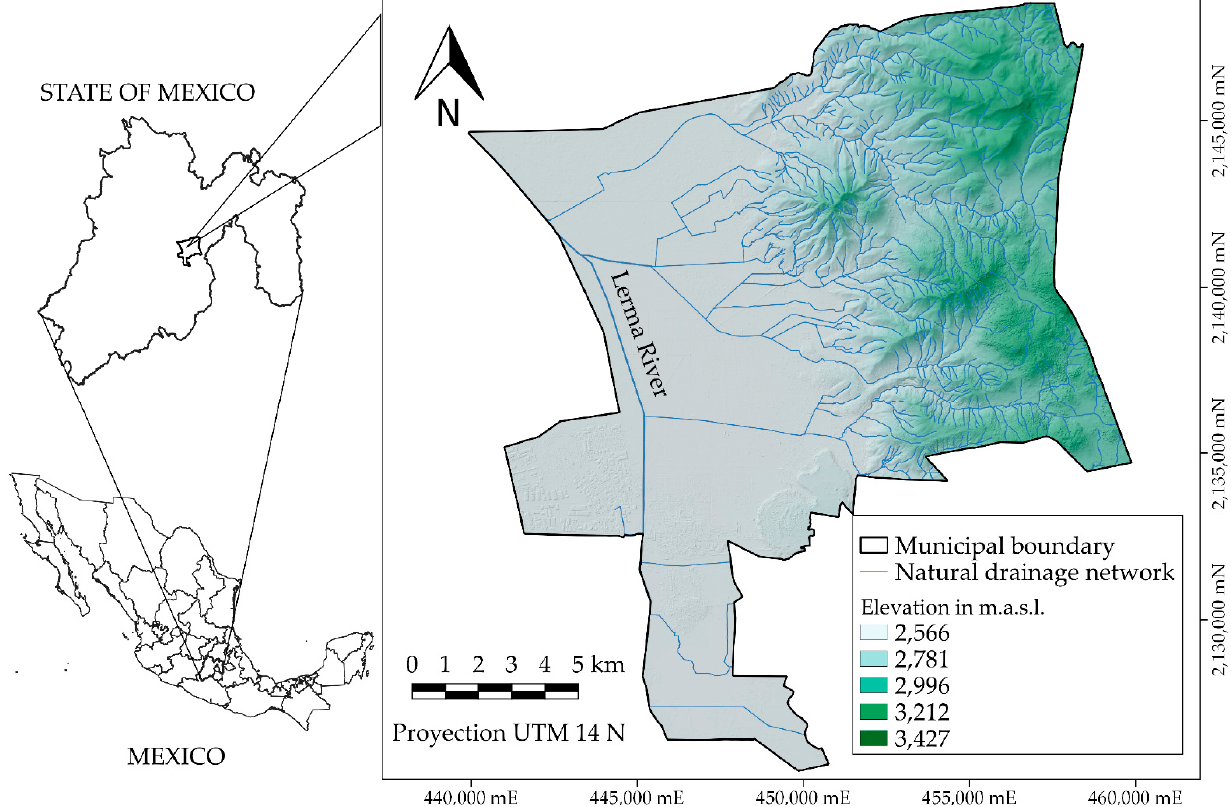
Figure 1. Study area in the Municipality of Lerma de Villada, State of Mexico. Table 1. Characteristics of the Sentinel-1 and Sentinel-2 satellite images